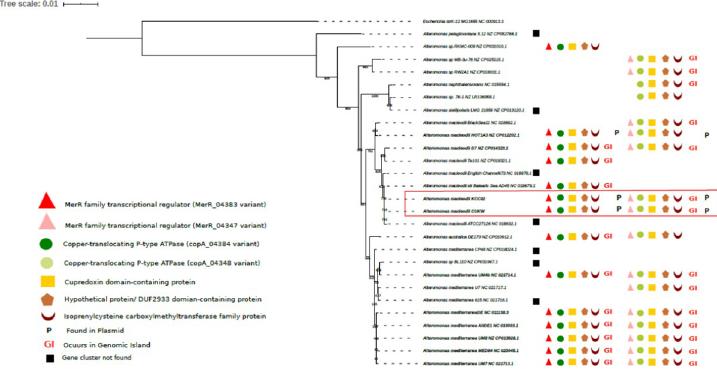
Fig 7. MerR-copA variant distribution among Alteromonas . Phylogenetic analysis of 16S ribosomal RNA sequence was done with all complete genomes of A . macleodii and A . mediterranea including a representative species from other Alteromonas genera available on NCBI RefSeq database. Escherichia coli was used as an outgroup to root the tree. The nucleotide sequences for 16S rRNA were downloaded from the NCBI database. Multiple sequence alignments of the sequences were performed using ClustalX and poorly aligned positions were filtered using Gblocks1. Phylogenetic trees were constructed using a bootstrap neighbor joining algorithm. The copA variants and surrounding gene clusters were mapped onto the phylogenetic distribution of 16S ribosomal RNA phylogeny using Inkscape editor. The two variants are differentiated by color. The two merR variants (MerR_04383 and MerR_04347) are shown as red and pink triangles, respectively. The two copA variants (CopA_04384 and CopA_04348) are shown as dark green and light green circles, respectively. “P” indicates the presence of the gene cluster on a plasmid and “GI” indicates the gene cluster occurs within a genomic island. The gene cluster found in A . macleodii strains CUKW and KCCO2 are highlighted in